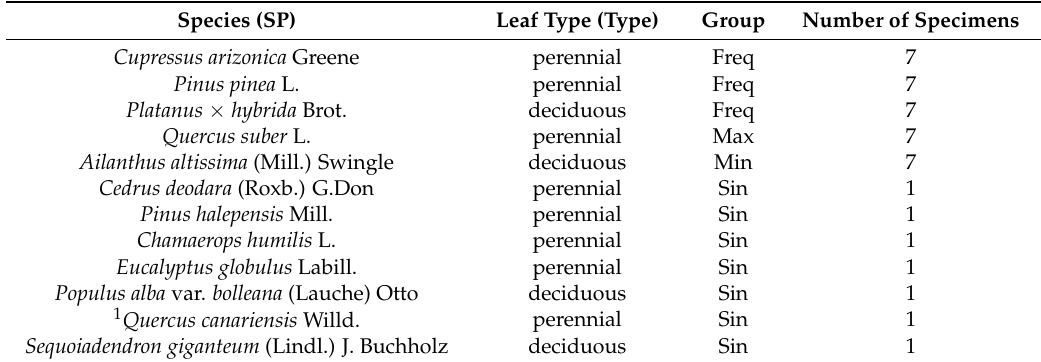
Table 1. Specimens selected in the study grouped by their factors. Species